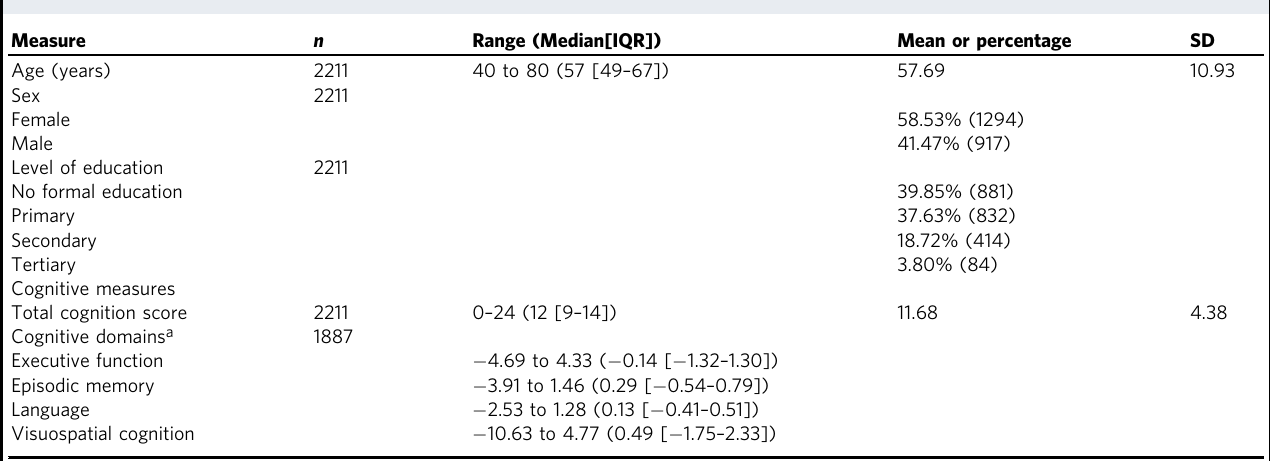
Table 1 Descriptive statistics showing cognitive trait and covariate